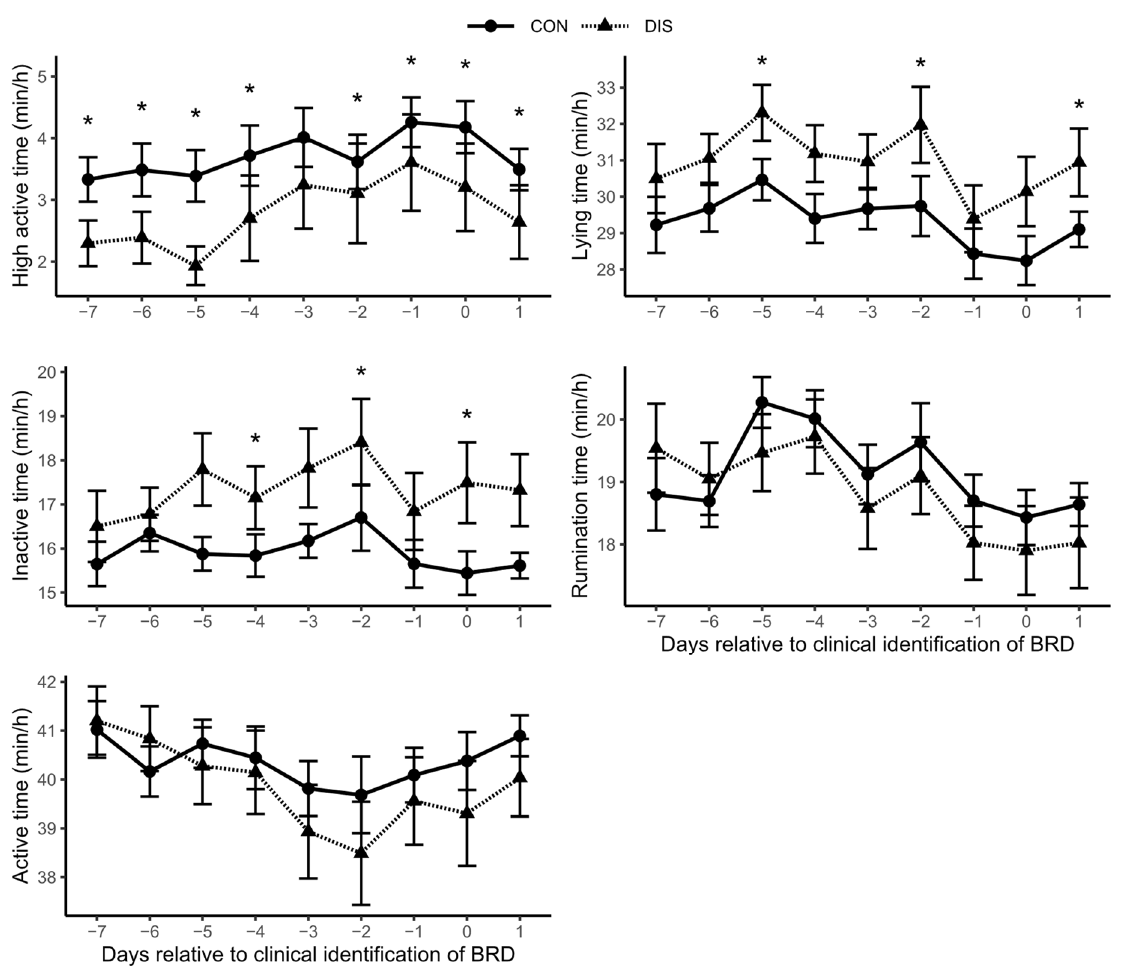
Figure 1. High active, inactive, active, lying and rumination times for diseased calves (DIS = 41) and clinically healthy controls (CON = 69) from d − 7 to d +1 relative to clinical diagnosis of bovine respiratory disease (BRD) (d 0). * changes between groups with a p < 0.05 based on Mann–Whitney U test. Error bars represent standard error of the mean (SEM).